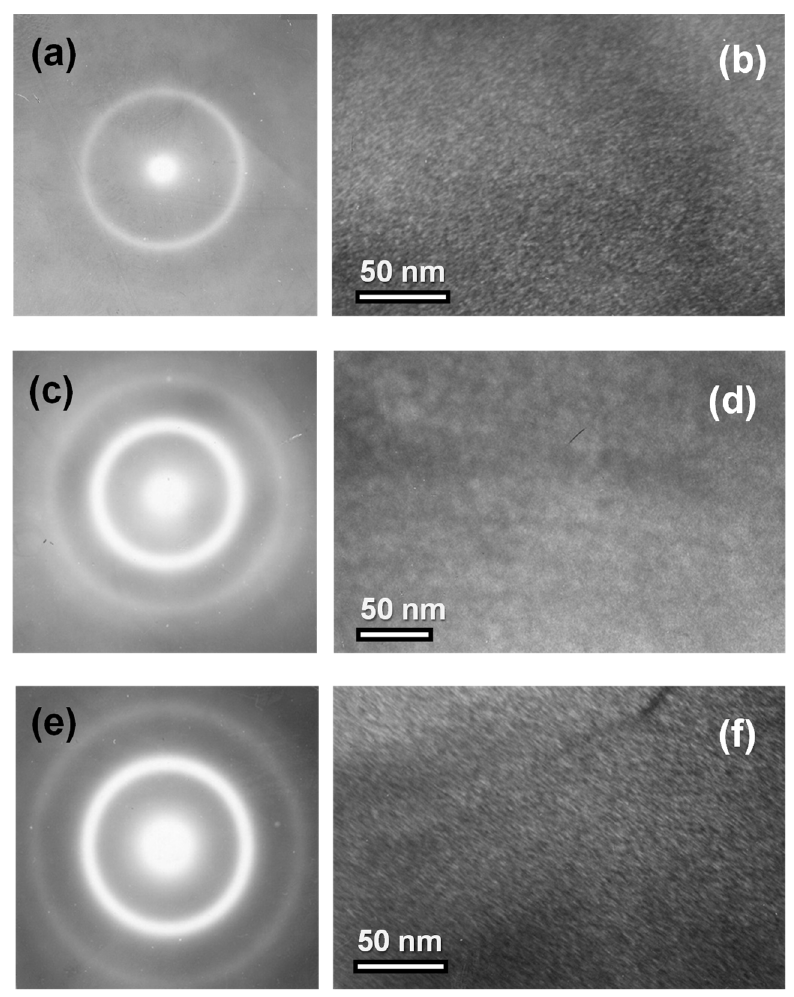
Figure 3. Microdiffraction patterns ( a , c , d ) and electron micrographs ( b , d , e ) for Fe 3 Co 67 Cr 3 Si 15 B 12 rapidly-quenched ribbons in following states: AP ( a , b ); AN ( c , d ); and SA ( e , f ) (see also Table 1).